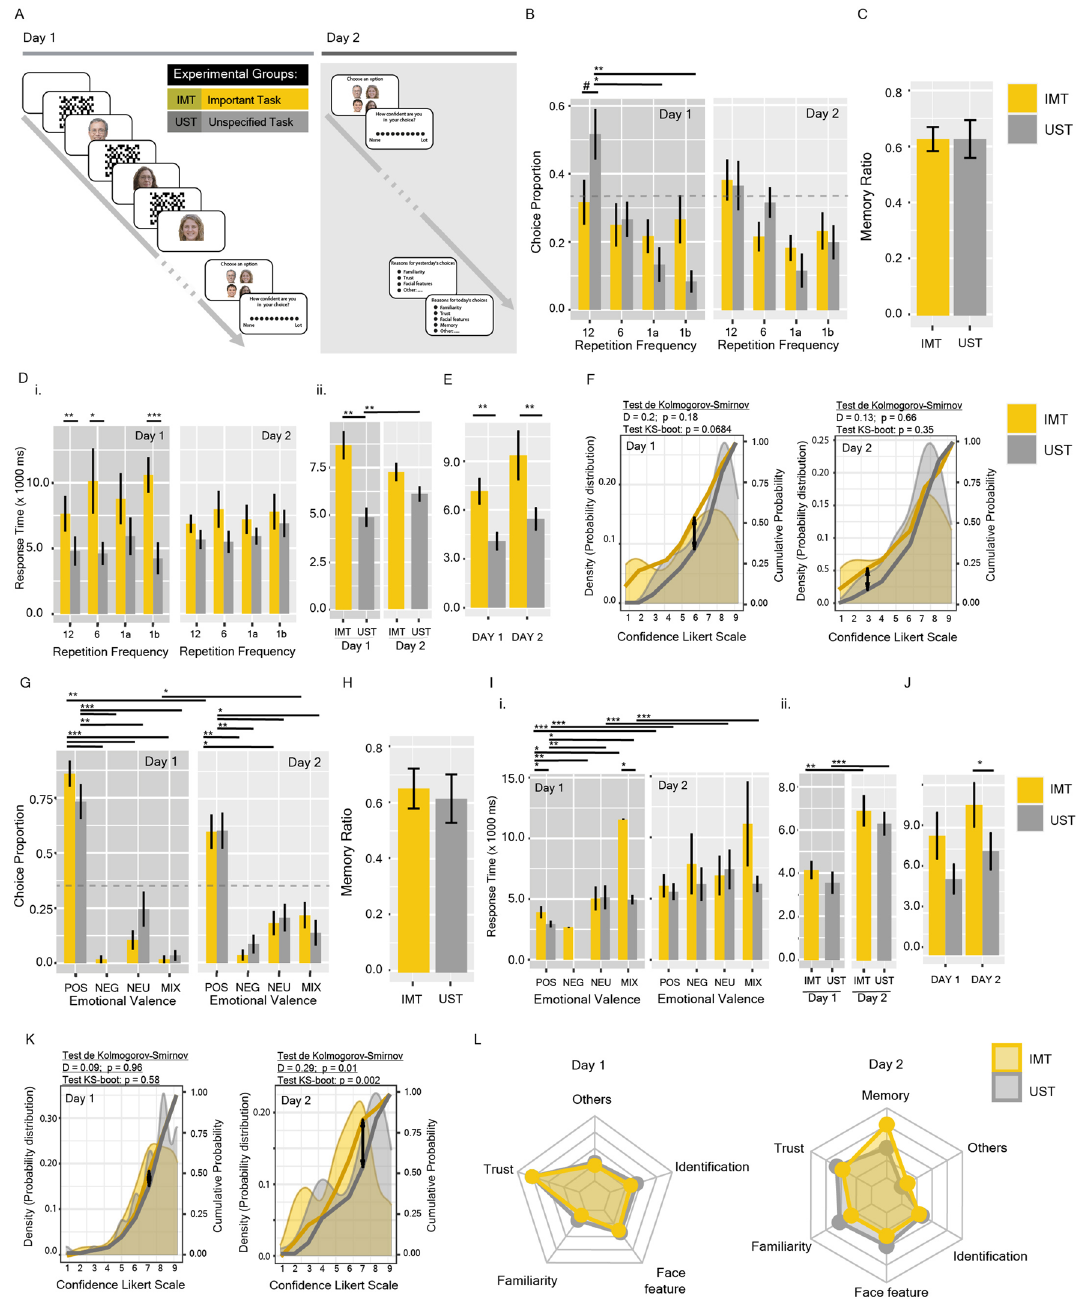
Figure 4. Long-term effects of repetition and emotional semantic primings. ( A ) Experimental design for Synchronic Experiment #1. ( B – F ) Synchronic Experiment #1: ( B ) Choice Preference (as the proportion of the chosen face over a total of 3 trials) at day 1 and day 2. ( C ) Memory Ratio, calculated as the number of faces that were chosen again on day 2 over the total number of choices. ( D ) Response time separated by chosen frequency (i) or group (ii). ( E ) Response time for Control #1. ( F ) Probability Distribution of reported confidence. Areas show the density probability distribution; yellow and grey lines show the cumulative probability. Differences in the cumulative probabilities were analysed by the Kolmogorov–Smirnov (KS) Test: the arrow revealed the highest distance between distributions. ( G – K ) Synchronic Experiment #2: ( G ) Choice Preference (as the proportion of the chosen face over a total of 3 trials) at day 1 and day 2. ( H ) Memory Ratio, calculated as the number of faces that were chosen again on day 2 over the total number of choices. ( I ) Response time separated by chosen emotional valence (i) or group (ii). ( J ) Response time for Control #1. ( K ) Probability Distribution of reported confidence. ( L ) Stated reasons for the choices of day 1 and day 2. Spider chart shows frequency of selection of each reason. Bars shown mean ± SEM. The grey dashed line represents the expected proportion for random choice (null hypothesis). # p = 0.0567, *p < 0.05, **p < 0.01, ***p <